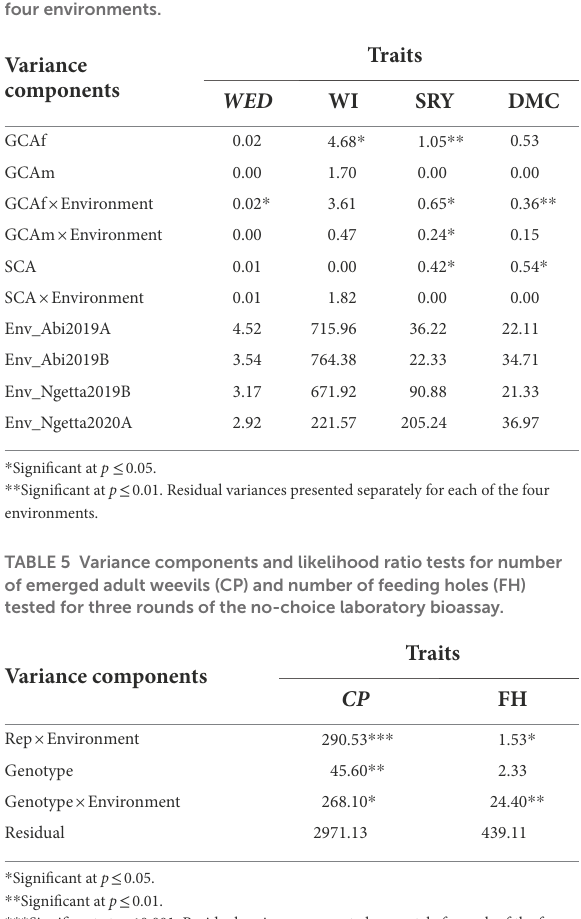
In the no-choice feeding bioassay, predicted means for the number of adult weevils in families ranged from 55 to 59. The